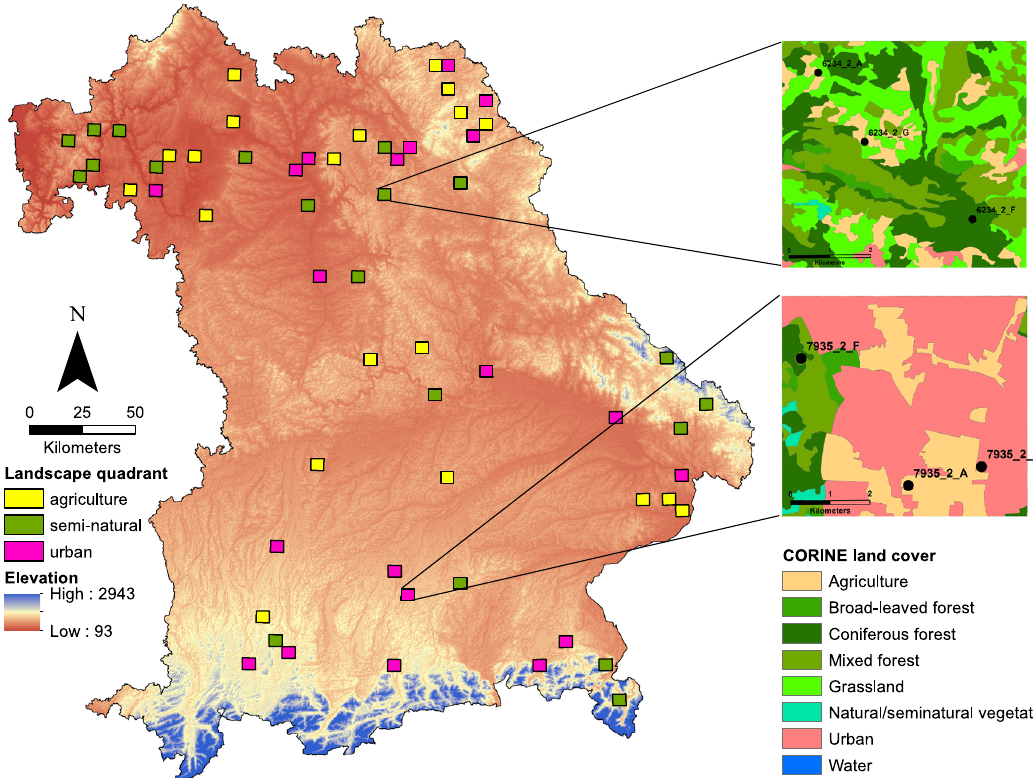
Fig. 1 Overview of the study design and the distribution of the 60 landscapes across the study region. The 60 quadrants were selected over gradients of elevation and land-use type within the federal state of Bavaria. The colors show the elevation. The insets show examples of a semi-natural and an urban- dominated landscape. The black dots represent the three plots set up in different habitat